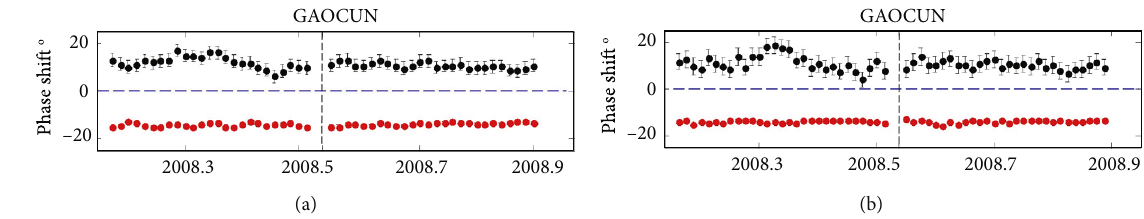
Figure 14: Phase shift to the O (black dots)/M (red dots) tide of water level in the Gaocun well calculated with a moving time window of 1 2 (a) 27.95/29.5 days and (b) 15 days. The dashed lines indicate the occurrence time of the 2008 M w 7.9 Wenchuan